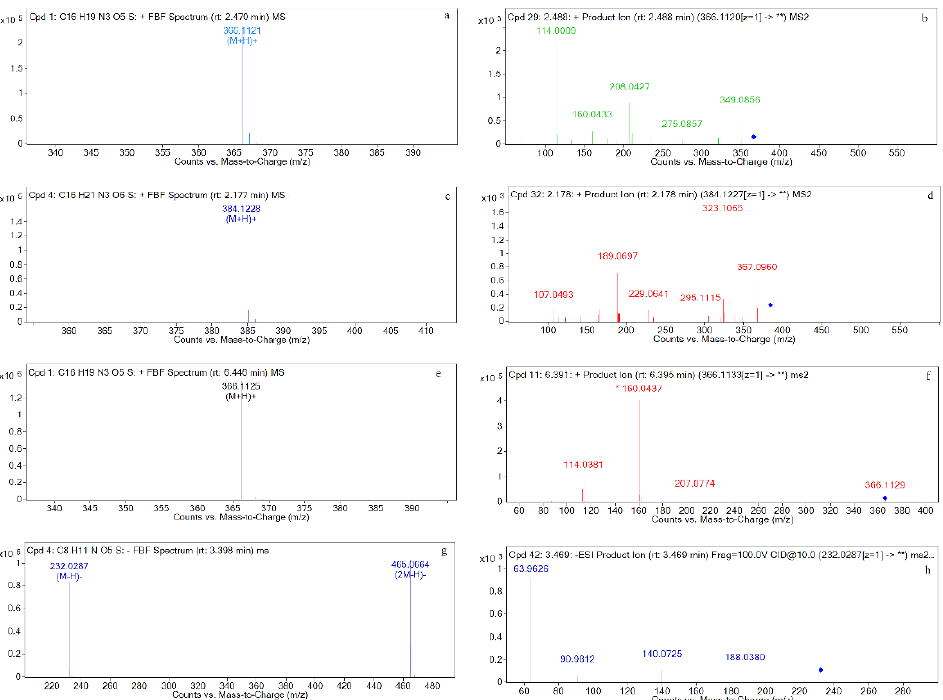
Figure 12. Mass spectra of four metabolites M1, M2, M3, and M4. ( a ) Mass spectrum of M1; ( b ) Two-stage mass spectral data of M1; ( c ) Mass spectrum of M2; ( d ) Two-stage mass spectral data of M2; ( e ) Mass spectrum of M3; ( f ) Two-stage mass spectral data of M3; ( g ) Mass spectrum of M4; ( h ) Two-stage mass spectral data of M4.